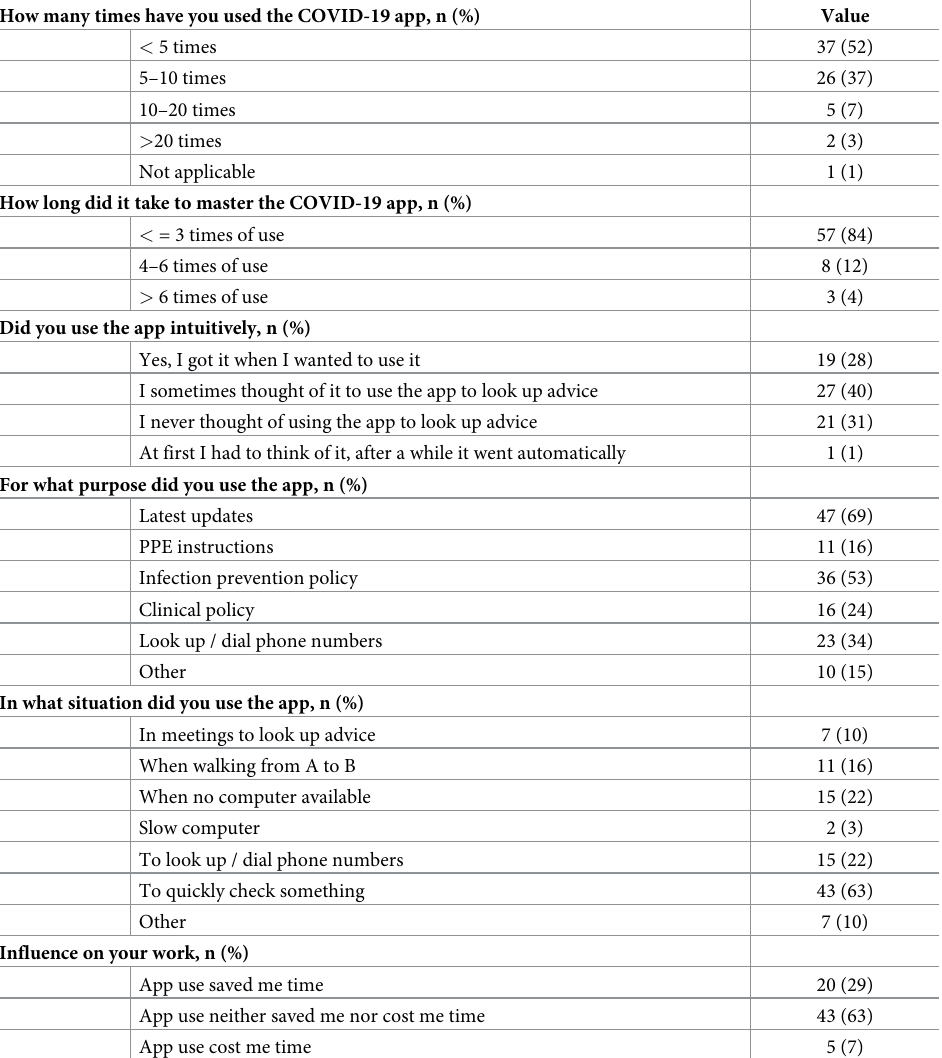
Table 5. COVID-19 app use (N =